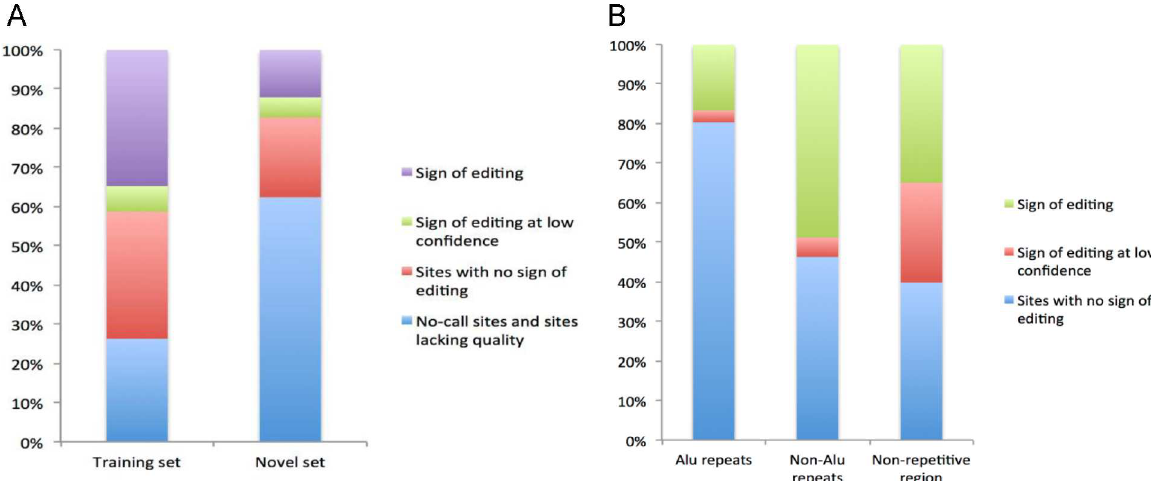
Fig 5. Validation of putative A-to-I RNA editing events. (A) A-to-I RNA editingevents observedin human islets for 3893 known sites (training set) and 561 putative sites (novel set). In the training set, 1352 sites show signs of editing, 257 sites show signs of editing but at a low confidence, 1260 sites including 506 SNPs do not show any sign of editing and 1024 no-callsites. In the novel set, 68 sites show signs of editing, 29 sites show signs of editingbut at a low confidence, 114 sites including8 SNPs do not show any sign of editingand 350 no-call sites. (B) The observed A-to-I RNA editing events in Alu repeats, non-Alu repeats and non-repetitive region in human islets. There are 11, 2 and 53 sites in Alu repeats, 20, 2 and 19 sites in Non-Alu repeats and 36, 26 and 41 sites in non- repetitive region show signs of editing, signs of editingat low confidenceand no sign of editing,